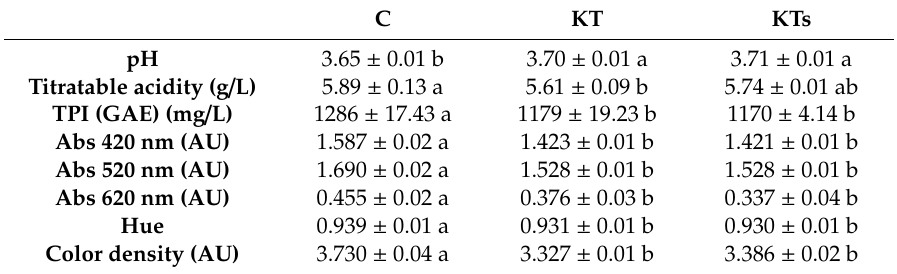
Table 1. Oenological parameters of red wines after 7 days of treatments. In the same row, di ff erent letters indicate significant di ff erences according to Tukey’s test ( p < 0.05). n = 3. C: no addition; KT: 0.5 g / L of solid chitosan; KTS: 0.5 g / L of chitosan in solution. TPI: total phenolic index. GAE: gallic acid equivalent. AU: absorbance